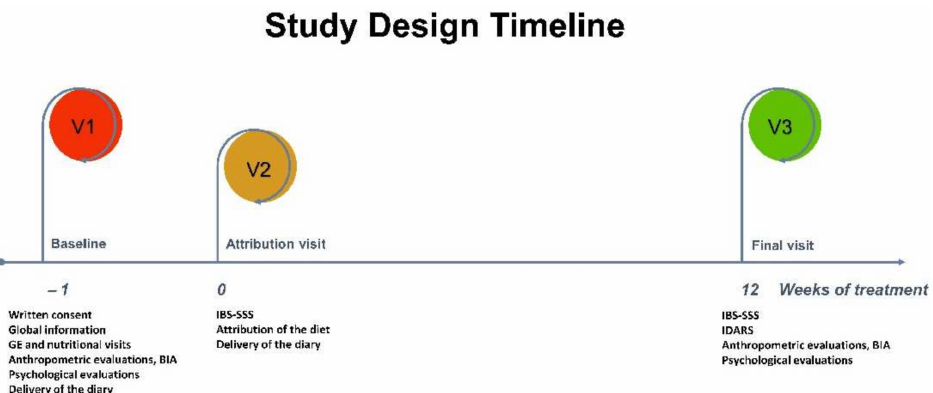
Figure 1. The study design timeline. GE: Gastrointestinal examination; BIA: Bioelectrical impedance analysis; IBS-SSS: IBS Symptom Severity Scale; and IDARS: IBS diet-adherence report